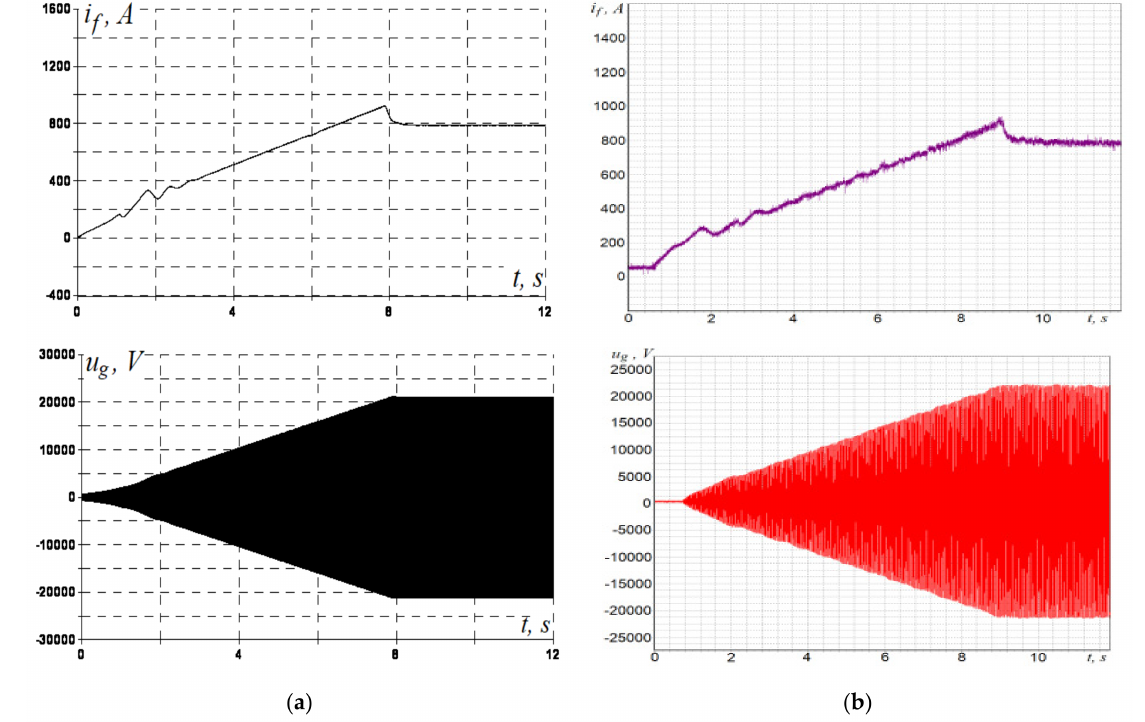
Figure 5. ( a ) Simulation in the hybrid system; ( b ) experimental results of the field current ( i f ) and terminal voltage of the generator ( u g , instantaneous value) for the initial excitation of the generator.